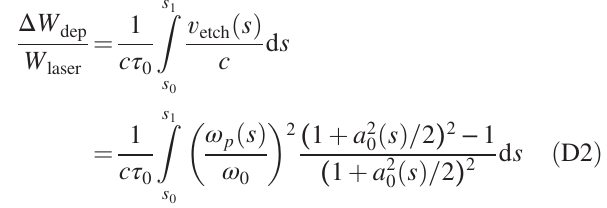
perfect acceleration conditions similar to an unperturbed LWFA scenario and, unlike LWFA, retains these conditions over the complete acceleration length defined by the spatial extent of the TWEAC pulse projected onto the electron path of propagation.